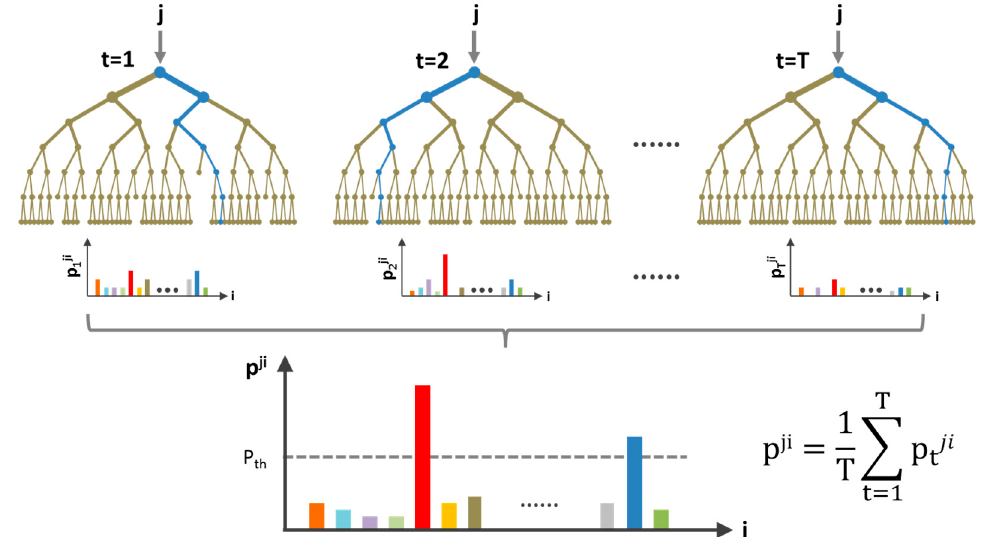
Figure 9. Random forest classifier for fiducial-based features. j represents an unknown subject; T is the total number of decision trees used in the random forest algorithm; N is the total number of subjects stored in the database; and P ji is a probability vector with size N , indicating j as being classified as any subject i ( i = 1, . . . N ) in the database.